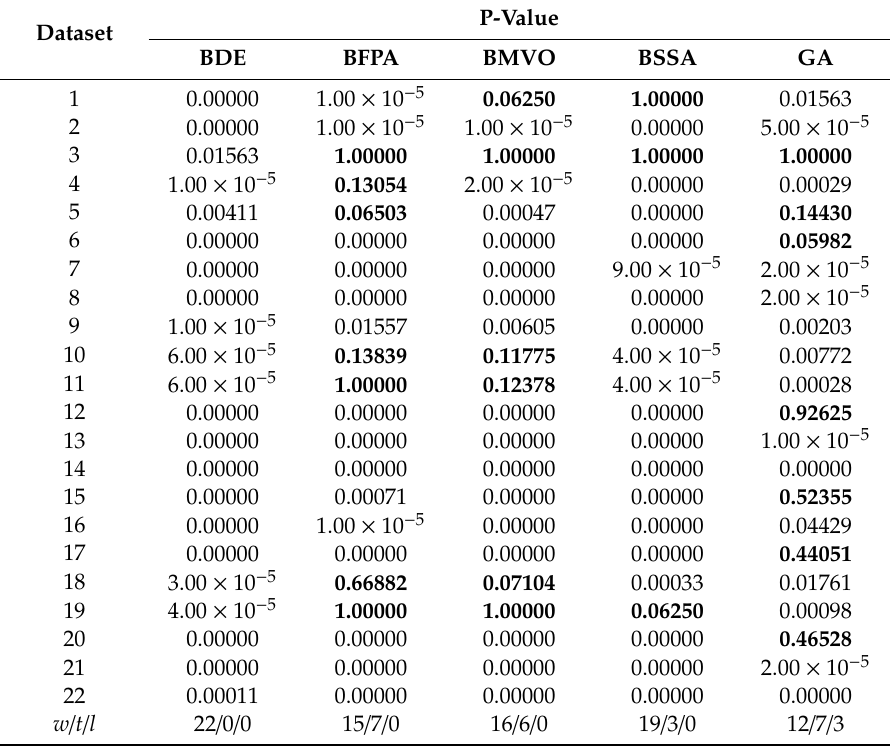
Table 15. P -values of Wilcoxon signed-rank